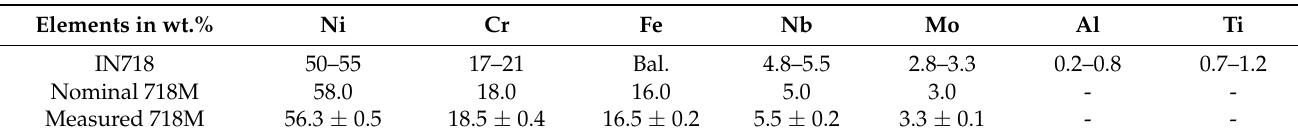
Table 1. Composition of the single-crystal cast alloy 718M measured by µ -XRF in comparison with commercially avail- able IN718. Elements in